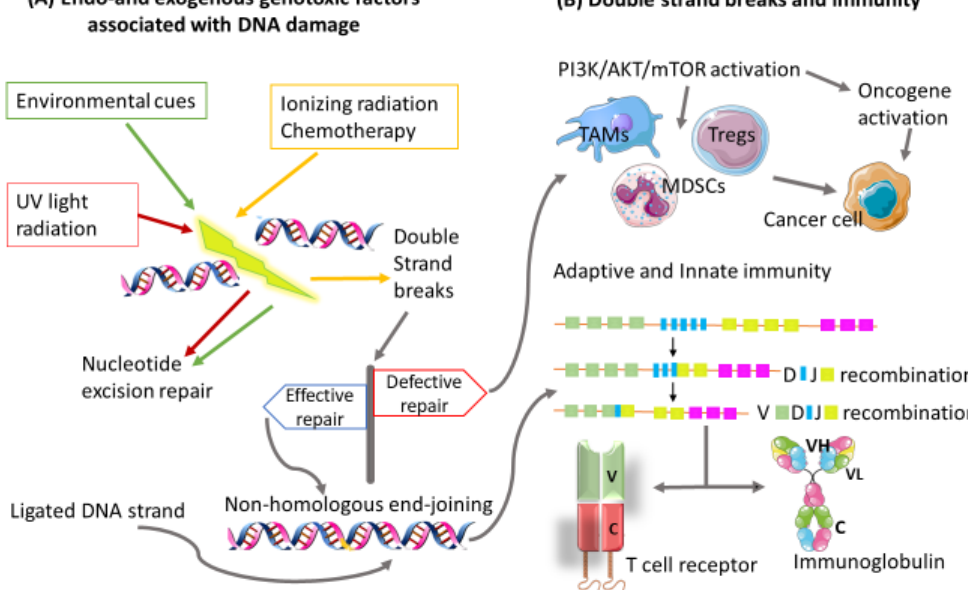
Figure 1. Impaired transcription and replication processes can occur, leading to DNA damage and genomic instability. ( A ) DNA damage can be a result of multiple factors, which could be of an endo or exogenous nature. ( B ) Repair of double-strand breaks (DSBs) is crucial to cell development and survival. DSBs are repaired without the need for a homologous template by the nonhomologous end-joining pathway. Consequently, an efficiently ligated DNA strand results in a heterogenous pool of antigen receptor genes needed for T and B cell development. Failure of the DSB repair mechanism activates the PI3K/AKT/mTOR signaling pathway, which induces immunosuppressive cells known to promote cancer progression. Variable region (v), Constant region (c), Heavy chain (H), Light chain (L).